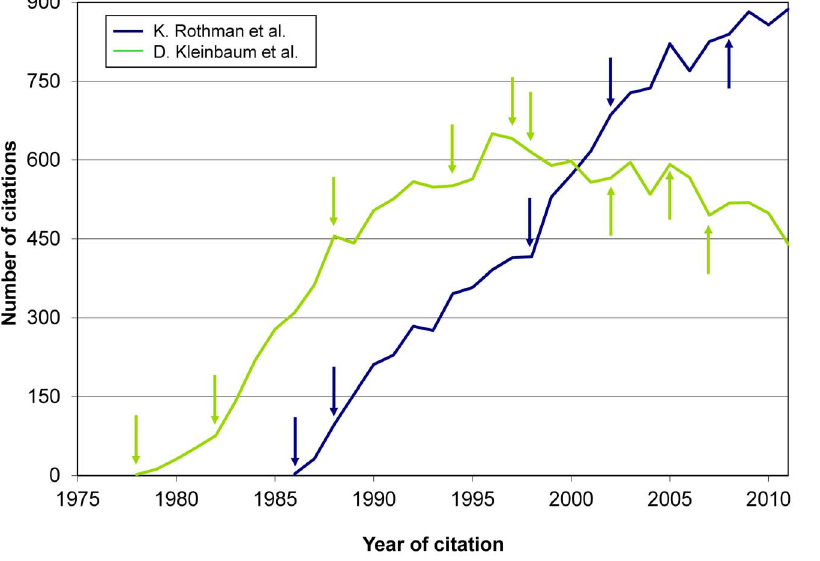
Figure 10. Citations to 3 books by K. Rothman et al. (12,962 citations) and 4 books by D. Kleinbaum et al. (14,613 citations). [Footnote: Arrows show the year of publication of all editions of each book. ]